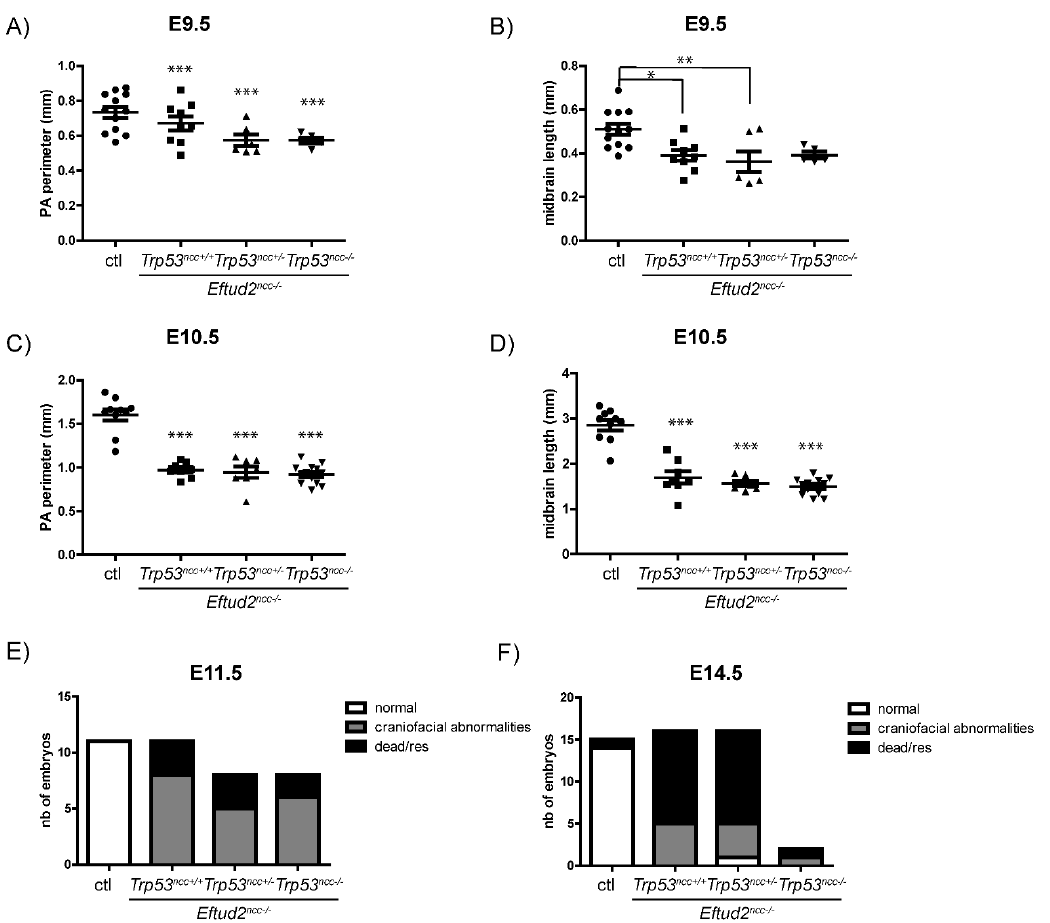
Figure 5. Removing Trp53 does not improve midbrain and pharyngeal arch growth or improve sur- vival of Eftud2 ncc − / − mutant embryos. Graphs showing that the perimeter of the first pharyngeal arch (PA) was significantly reduced in Eftud2 ncc − / − ; Trp53 ncc+/+ ( n = 9, E9.5, n = 8, E10.5), Eftud2 ncc − / − ; Trp53 ncc+/ − ( n = 6, E9.5, n = 7, E10.5) and Eftud2 ncc − / − ; Trp53 ncc − / − ( n = 5, E9.5, n = 13, E10.5) embryos at ( A ) E9.5 and ( C ) E10.5 when compared to controls ( n = 12, E9.5, n = 10, E10.5). Graphs showing that the length of the midbrain was reduced in Eftud2 ncc − / − ; Trp53 ncc+/+ and Eftud2 ncc − / − ; Trp53 ncc+/ − embryos compared to controls ( B ) at E9.5 ( D ) and also in Eftud2 ncc − / − ; Trp53 ncc − / − embryos at E10.5 when compared to con- trols. * p < 0.05, ** p < 0.01, *** p < 0.001 vs. control by ANOVA. Contingency graphs showing a similar proportion of normal, abnormal and dead or resorbed (res) embryos at ( E ) E11.5 and ( F ) E14.5 within each of these groups: controls ( n = 11, E11.5, n = 15, E14.5), Eftud2 ncc − / − ; Trp53 ncc+/+ ( n = 11, E11.5, n = 16, E14.5), Eftud2 ncc − / − ; Trp53 ncc+/ − ( n = 8, E11.5, n = 16, E14.5), and Eftud2 ncc − / − ; Trp53 ncc − / − ( n = 8, E11.5, n = 2, E14.5). At E14.5, four of the sixteen Eftud2 ncc − / − ; Trp53 ncc+/ − embryos were alive, among which one was phenotypically normal ( n = 7 litters). Alcian blue staining revealed no cartilage defects in the phenotypically normal Eftud2 ncc − / − ; Trp53 ncc+/ − mutant (Figure S3C). In con- trast, no phenotypically normal Eftud2 ncc − / − ; Trp53 ncc − / − embryo was recovered at this stage In phenotypically abnormal Eftud2 ncc − / − ; Trp53 ncc+/ − embryos ( n = 3) and in the Eftud2 ncc − / − ; Trp53 ncc − / − embryo, cartilage preparations with Alcian blue revealed se- vere craniofacial defects (Fig.S3). Meckel’s cartilage, which will form the lower jaw, was present and smaller in one Eftud2 ncc − / − ; Trp53 ncc+/ − embryo but absent in the remaining ( n = 2/3). This cartilage was not found in the single Eftud2 ncc − / − ; Trp53 ncc − / − embryo. The paranasal cartilage, nasal and basal portion of the trabecular plate and the orbital cartilage were missing in all the phenotypically abnormal mutants ( n = 4/4). The frontal cartilage was abnormally shaped (2/4) or absent (2/4) in the mutant embryos. Similarly, the alas temporalis cartilage was absent in Eftud2 ncc − / − ; Trp53 ncc+/ − (2/3) and Eftud2 ncc − / − ; Trp53 ncc − / − embryos and abnormally shaped in one Eftud2 ncc − / − ; Trp53 ncc+/ − embryo, while the basitrabecular process was absent in all the morphologically abnormal mutants (4/4). Similarly, cartilages of the chondocranium that are derived from head mesoderm,